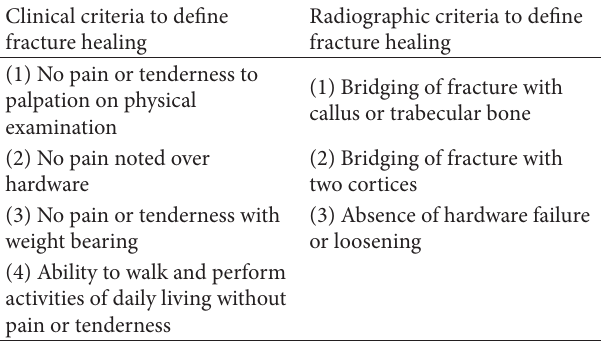
Table 1: It demonstrates the Corrales et al. [5] details of the syner- gistic effects of radiographic and clinical healing.